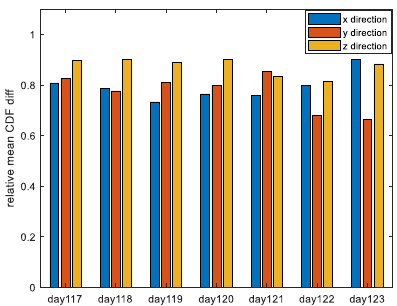
Figure 5. The rate of performance improvement with the MPO method compared to the PO method for all the three directions of the two paired overbound methods. The date is from 2017day117 to 2017day123. The results from PRN1 are taken as an example.